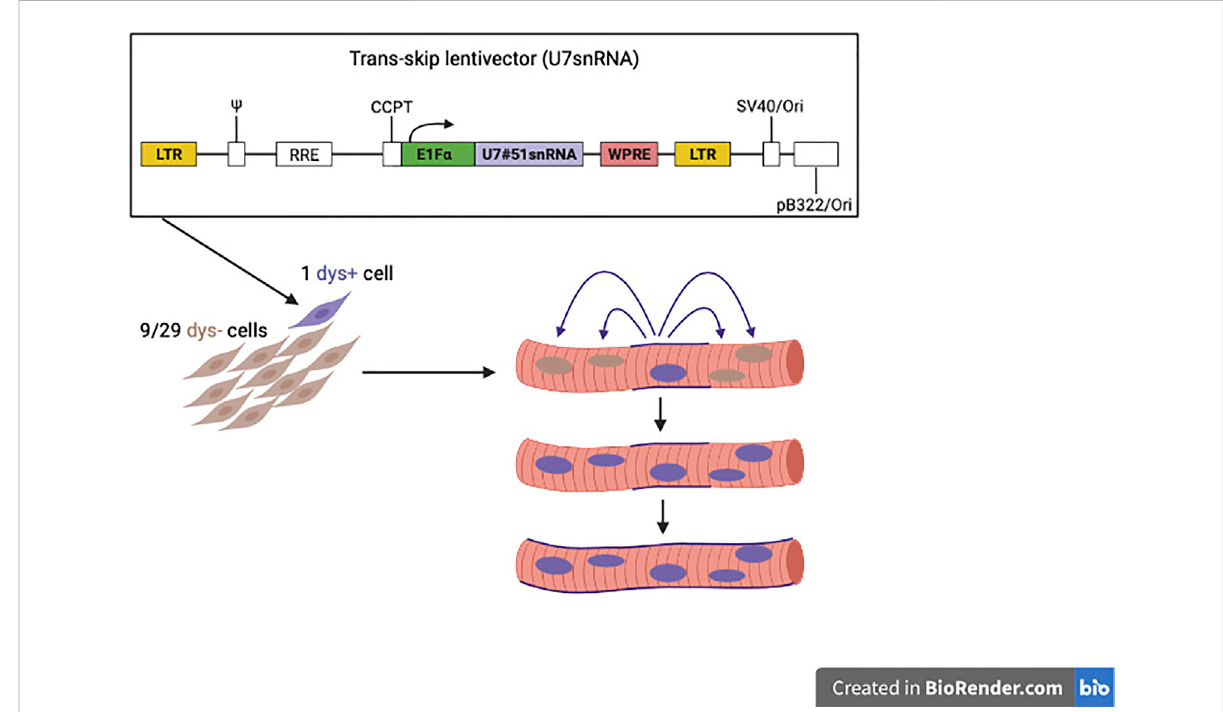
FIGURE 6 Novel strategy to reach quasi-normal expression of dystrophin, with donor cells working as “ trojan horses ” since the few nuclei penetrated inside the host fi bre correct also the resident nuclei, like the few Trojan warriors penetrated inside the horse donated by the Greeks, surprised the Troy residents during the sleep and managed to conquered the